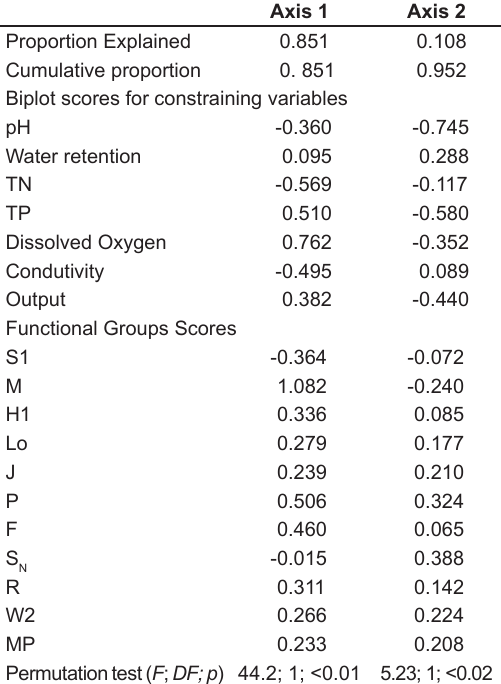
Table 6. CCA synthesis for 7 abiotic variables and func- tional groups of the first two axes and their respective cumulative proportions of the variance